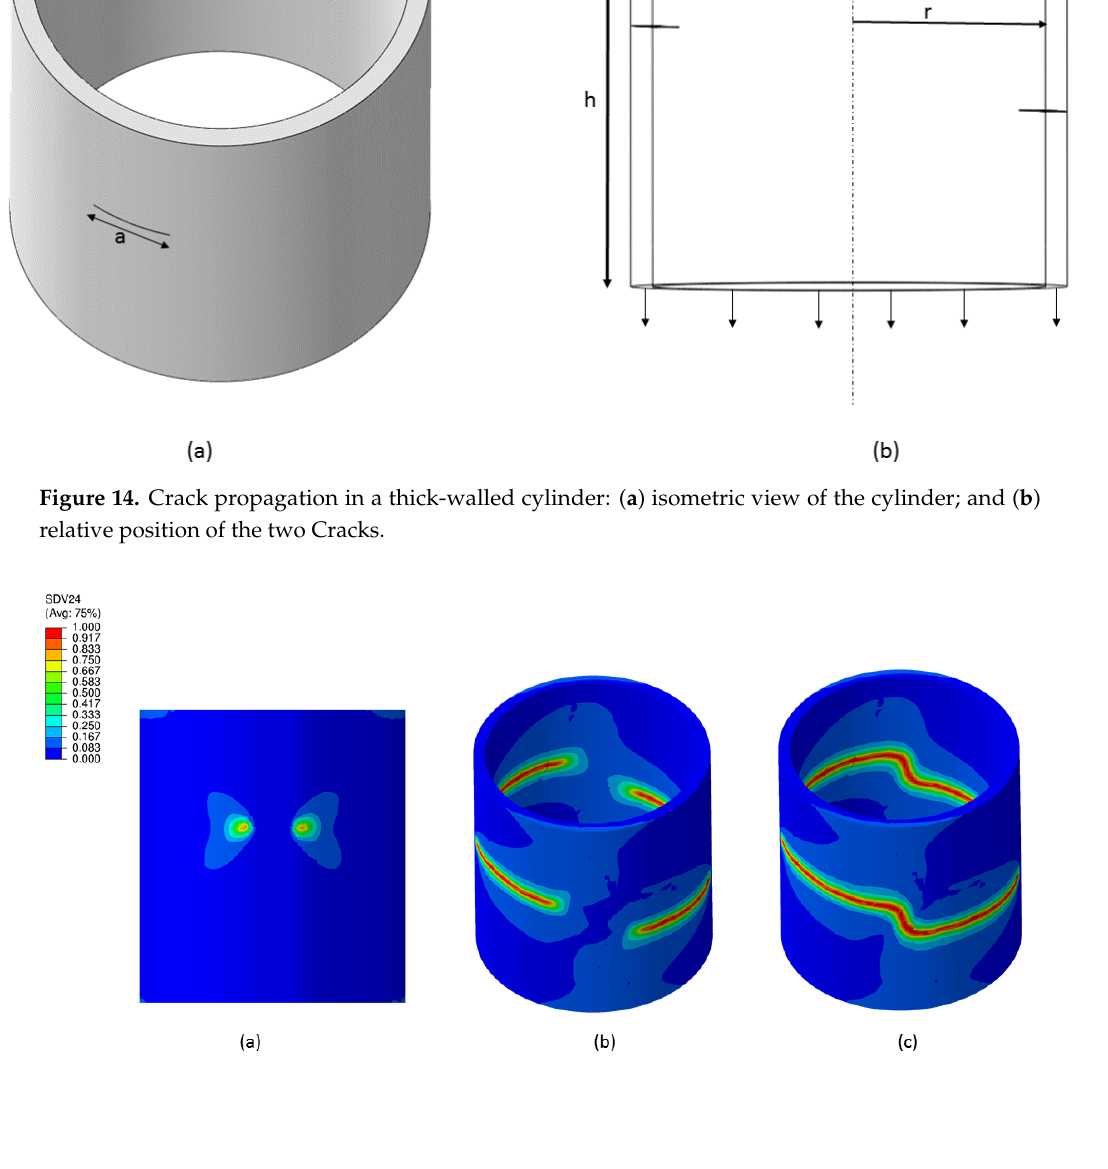
Figure 15. Crack propagation in a thick-walled cylinder: ( a ) crack initiation; ( b ) pattern of the two cracks propagating; and ( c ) final crack